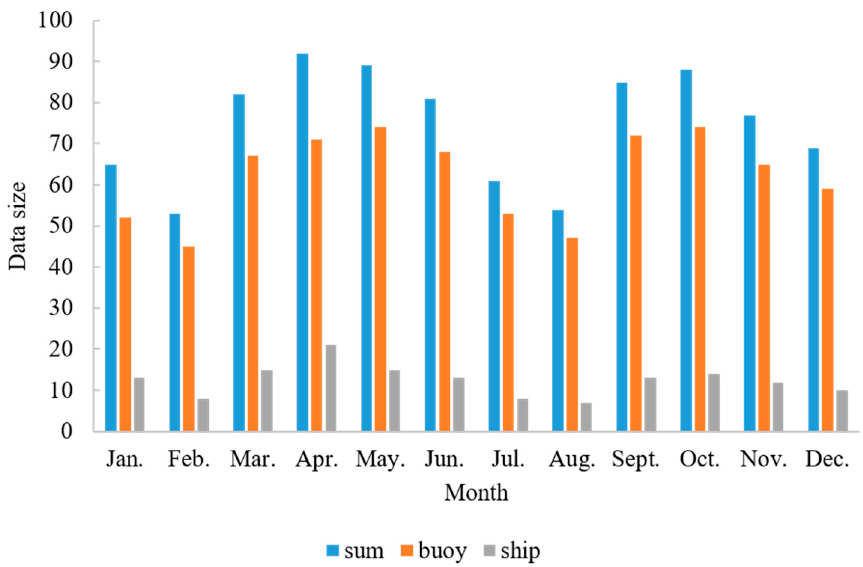
Figure 3. Data matching results between HY-1C image data and NEAR-GOOS real-time data.